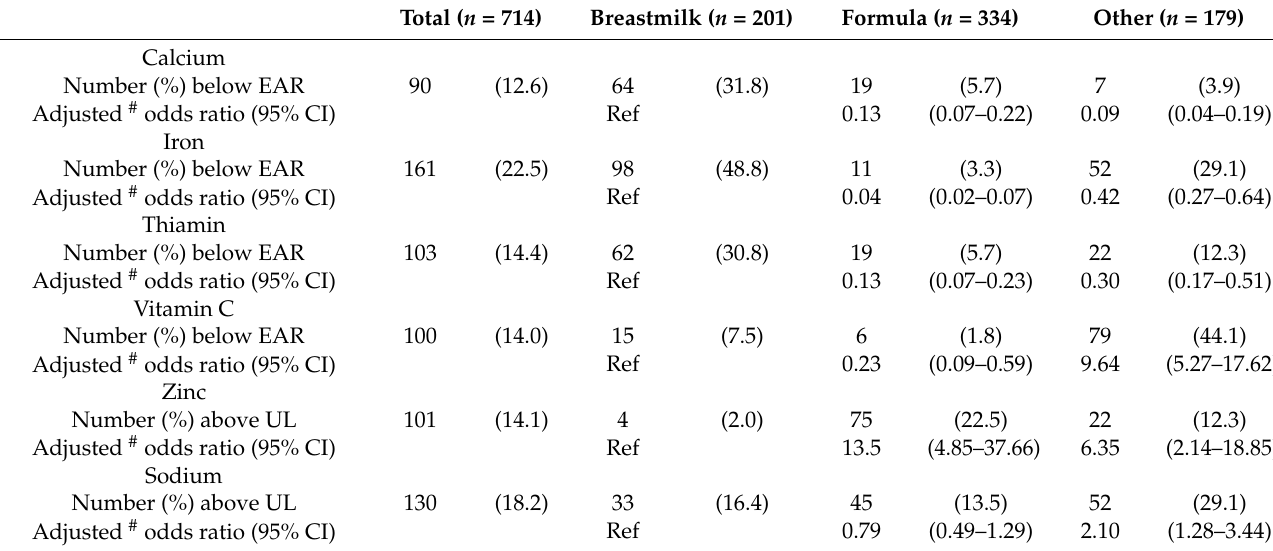
Table 4. Association between milk feeding method and intakes of selected ‡ micronutrients below the estimated average requirement (EAR) or above the upper level (UL) of